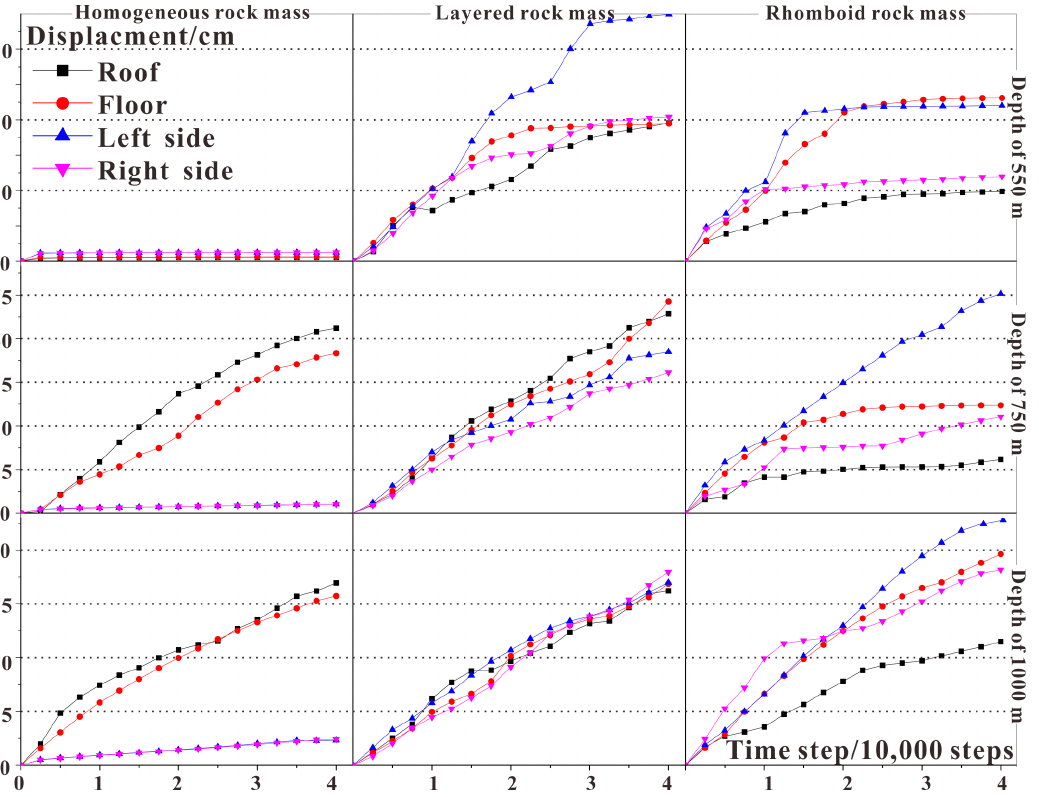
Figure 8. Displacement–time-step curves on important positions of the